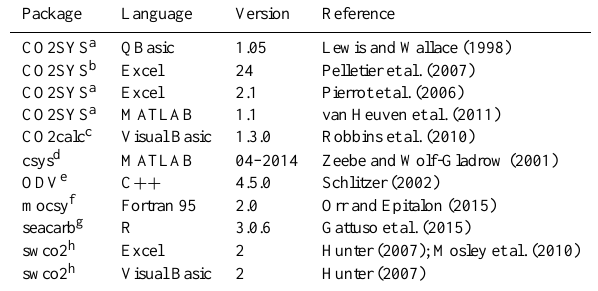
Table 1. Carbonate system software packages. Table 2. Computational time required to process the GLODAP- WOA2009 gridded data product a